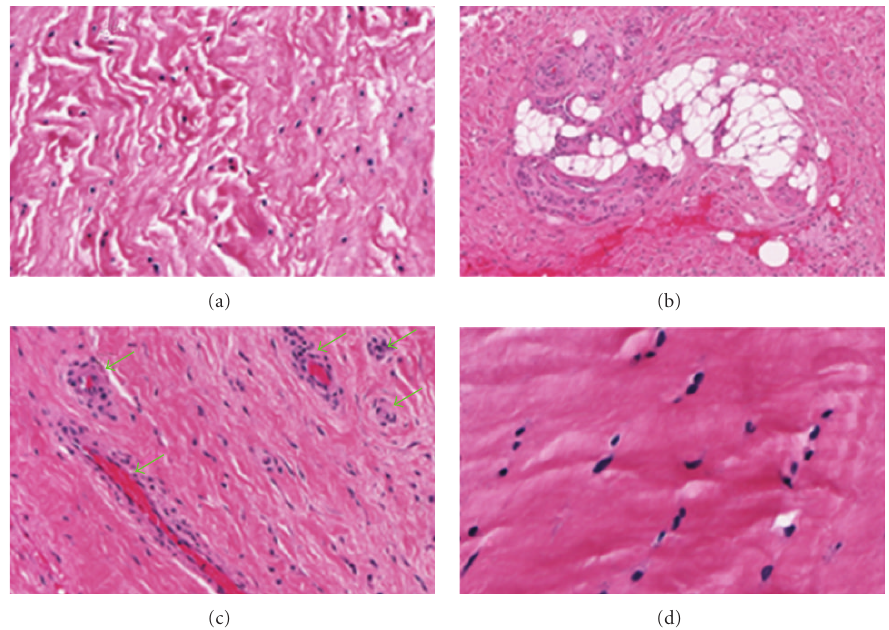
Figure 2: Tendinopathy in Rotator Cu ff Tendons (a) Fibre disruption (b) Adipose tissue deposition (c) Vascular hyperplasia (d) Rounding of nuclei (Courtesy of University of Western